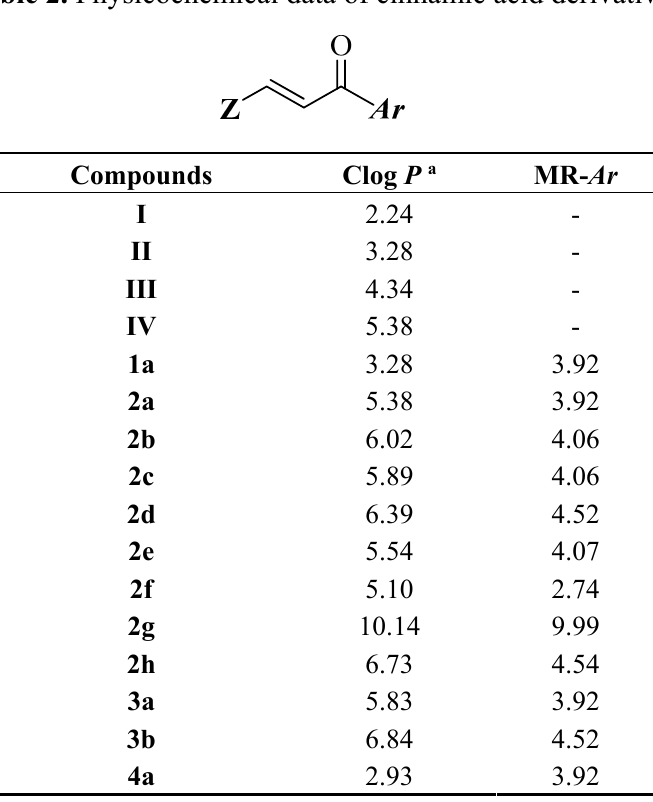
Table 2. Physicochemical data of cinnamic acid